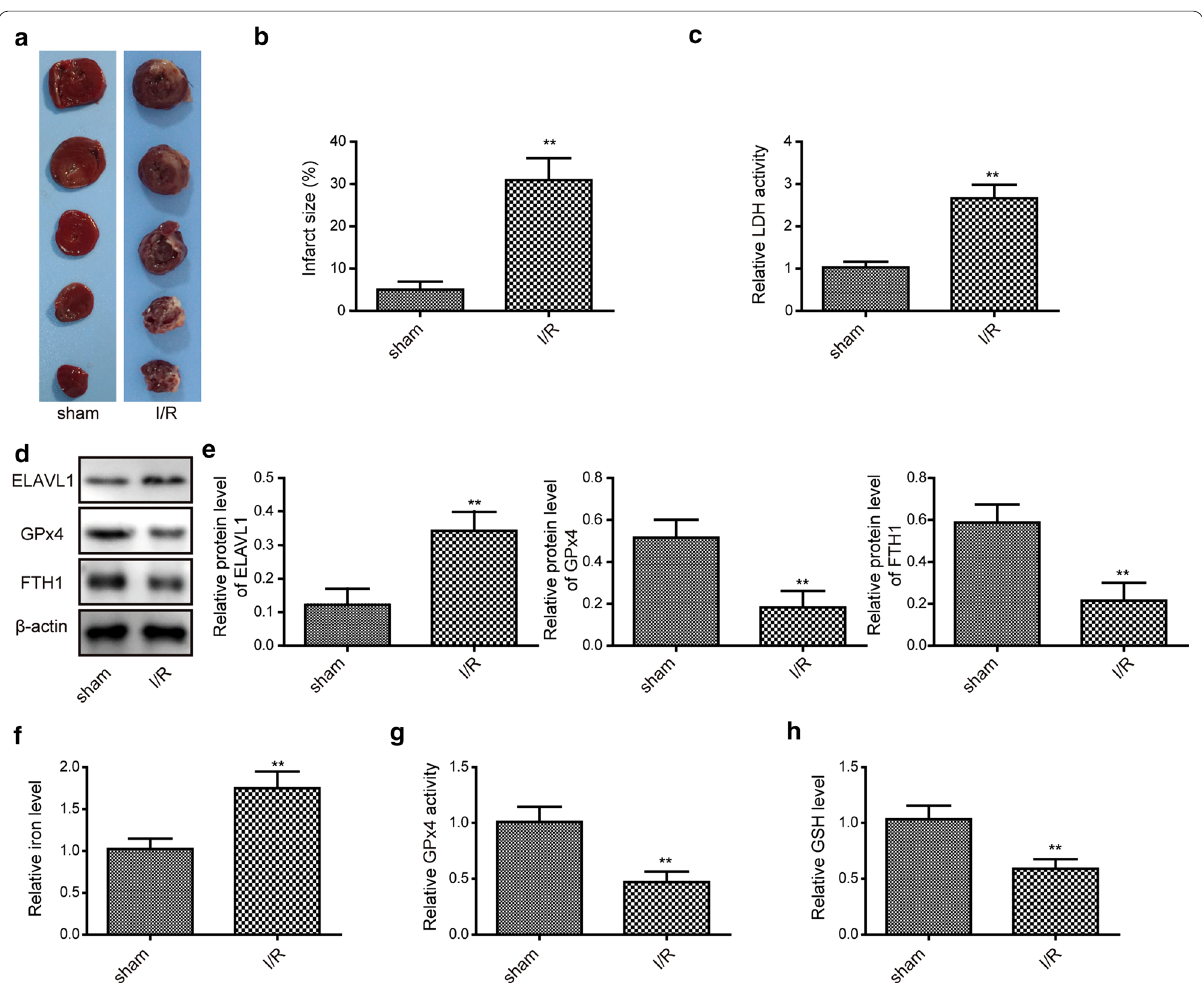
Fig. 1 Myocardial I/R induces ferroptosis and increases ELAVL1 expression level. Mice were subjected to myocardial I/R or sham surgery. a Representative TTC staining images of myocardial sections from sham‑surgery mice and I/R surgery mice. b Quantifications of infarct size in each group. c Relative LDH activity in sham‑surgery group and I/R group. d , e Relative protein levels of ELAVL1, GPx4, and FTH1 in sham‑surgery group and I/R group. f Relative cellular iron levels in sham‑surgery group and I/R group. g Relative GPx4 activity in sham‑surgery group and I/R group. h Relative cellular GSH level in sham‑surgery group and I/R group. The results were presented as the mean